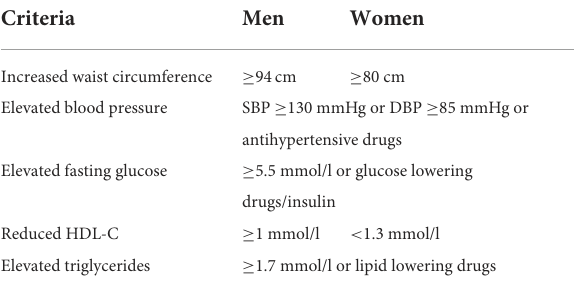
TABLE 1 Diagnostic criteria for the metabolic syndrome